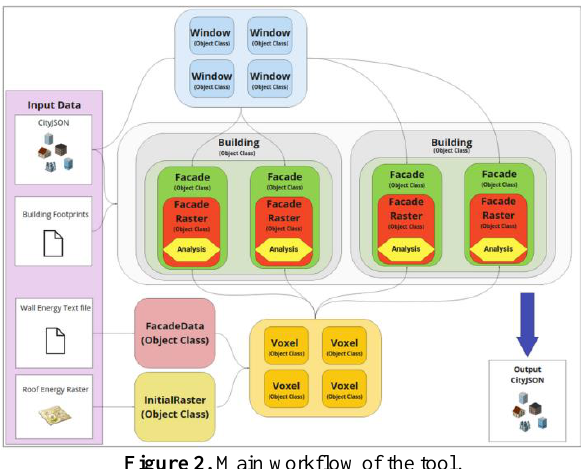
Figure 2. Main workflow of the tool.